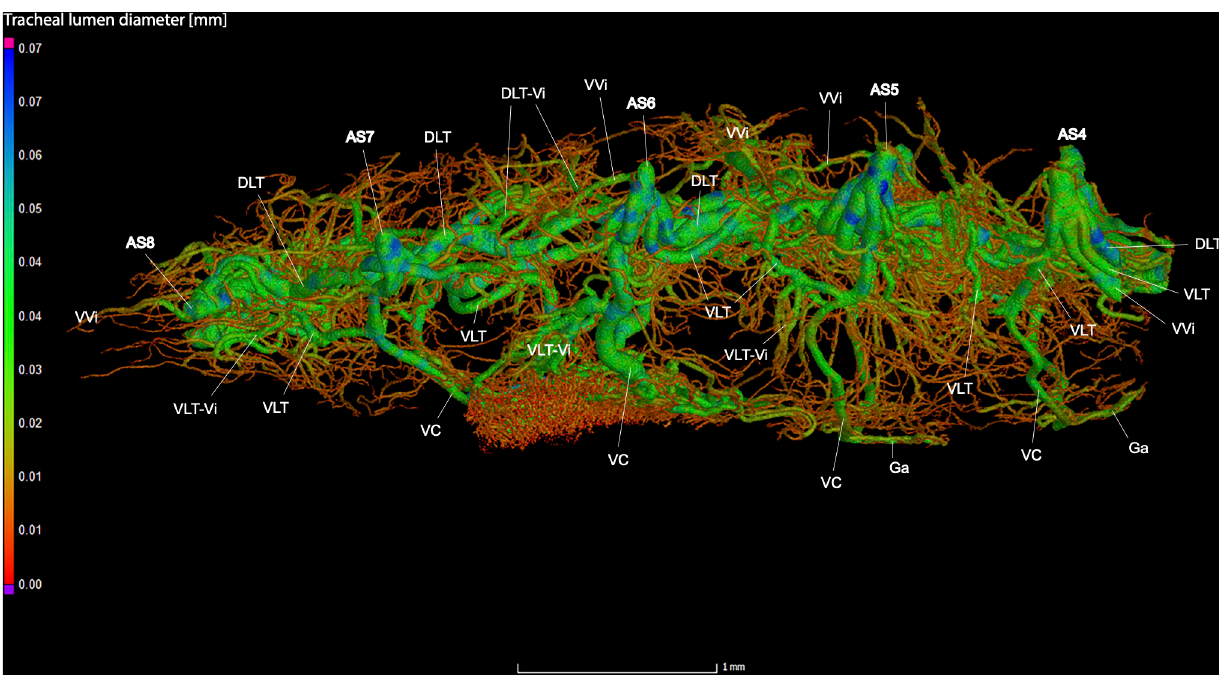
Fig 18. Lateral view of the abdominal tracheal system in adult female Photinus pyralis .